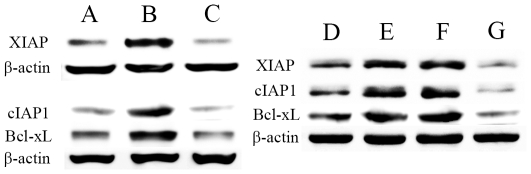
Effects of different treatments on NF-κB regulated anti-apoptotic factors.KTC-1 cells were left untreated as controls (A), or treated with 20 MBq/ml 131I (B) or in combination with 5 µmol/L Bay 11-7082 (C) for 24 hours. Then whole cell lysates were examined by Western blot for XIAP, cIAP1 and Bcl-xL. In the second set of experiments, control cells were left untreated (D). After no oligonucleotide (E), scrambled oligonucleotides (F) or p65 siRNA (G) transfection, KTC-1 cells were treated with 131I (20 MBq/ml) for 24 hours. Then protein levels of XIAP, cIAP1 and Bcl-xL were studied. β-actin was used as a loading control. Similar results were obtained in three independent experiments.